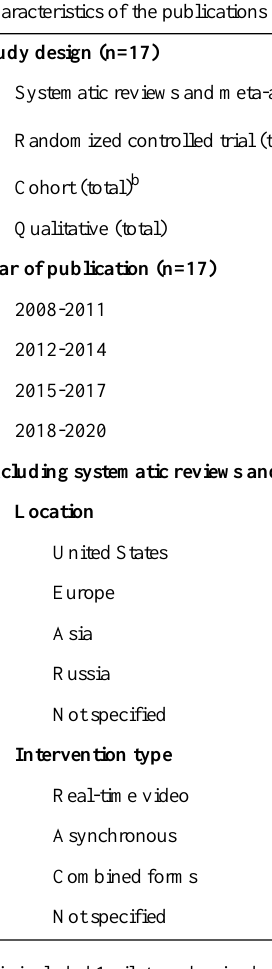
Values, n (%)Characteristics of the publications